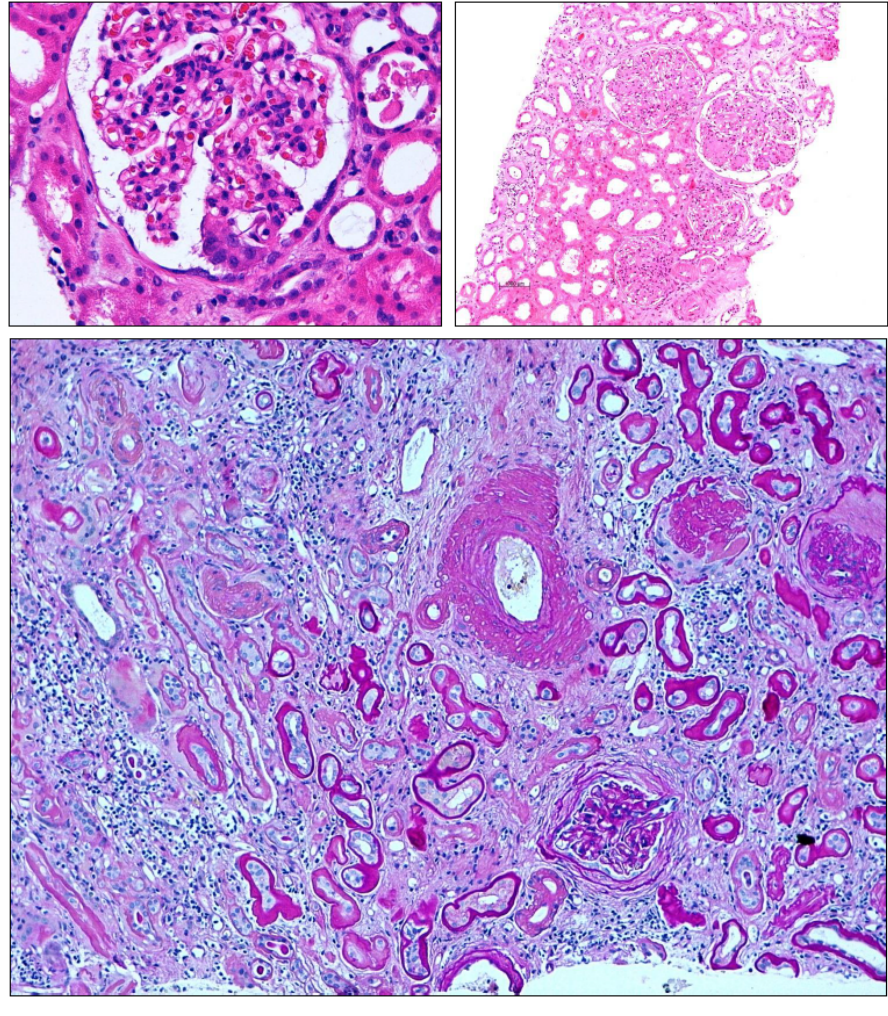
Figure 5. Insufficient epithelial repair results in mesenchymal repair. Loss of glomerular epithelial cells (podocytes) cannot be easily repaired in adults leading to focal-segmental glomerulosclerosis ( upper left ). Global glomerulosclerosis ( upper right ) results from the progression of focal-segmental lesions or as a consequence of diffuse and persistent disease mechanisms such as diabetes, hypertension, or immune complex glomerulonephritis. Here also, mesangial cells contribute to the sclerosis by excess production of mesangial